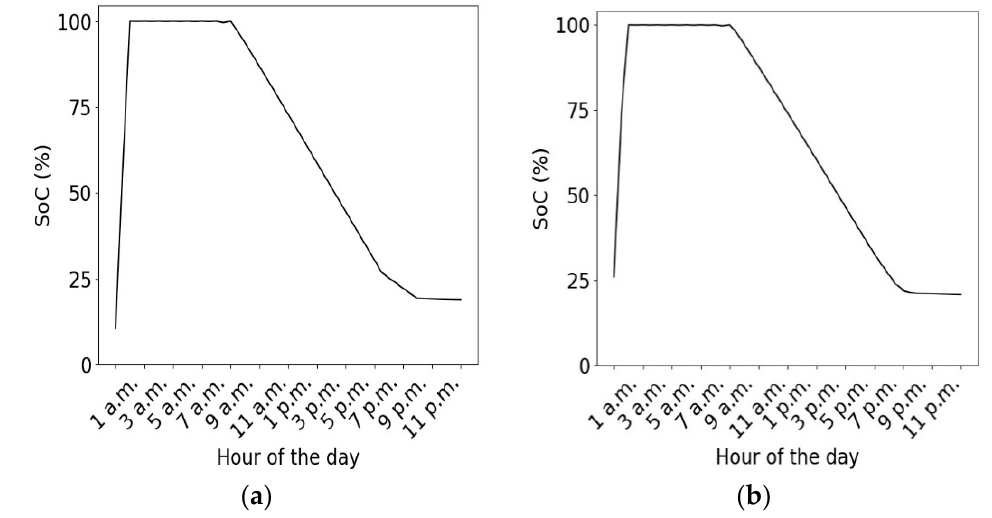
Figure 6. Battery charge period in a working day in the selected zone of the building. ( a ) Train/Dev sample division; ( b ) Test sample division.